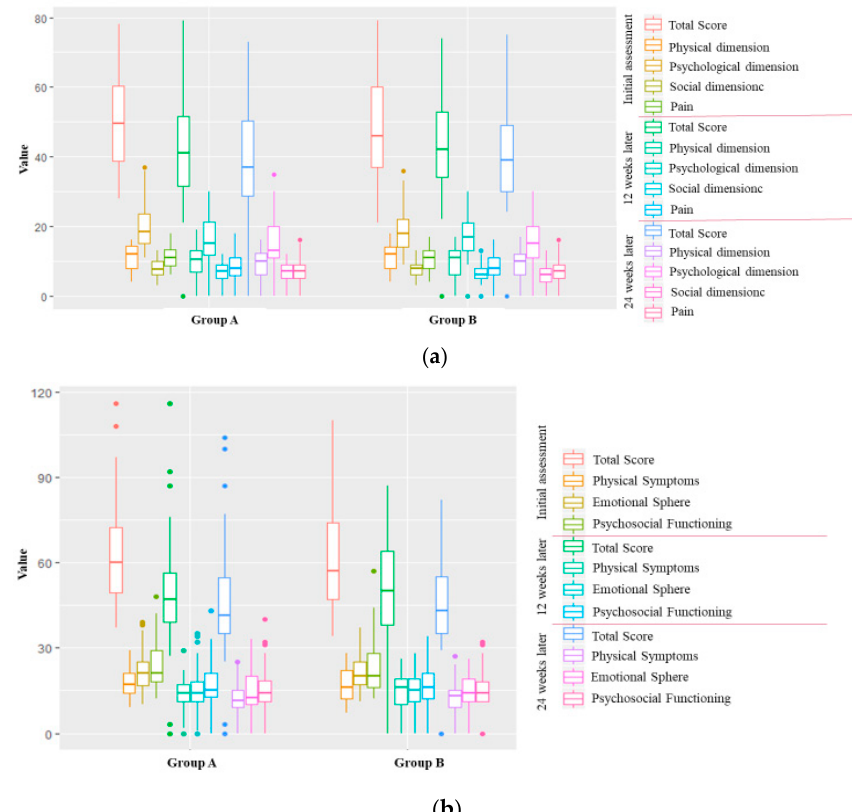
Figure 2. Box plots of changes in quality of life in the consecutive weeks of observation in the study groups. ( a ) Changes in quality of life according to the CIVIQ scale. Correlation between wound healing progress and changes in quality of life (total CIVIQ score): R (Group A) = 0.87, p = 0.000; R (Group B) = 0.85, p = 0.000. ( b ) Changes in quality of life according to the SKINDEX-19 scale. Corre- lation between wound healing progress and changes in quality of life (total Skindex-19 score): R (Group A) = 0.79, p = 0.001; R (Group B) = 0.76, p = 0.000. R—Spearman’s rank correlation coefficient; (A)—group A; (B)—group B; p —value. The mean pain intensity decreased significantly during the intervention; after 12 weeks, it decreased by 3.07 points in group A, and by 2.49 points in group B. In the fol- lowing 12 weeks, the change in average pain intensity occurred only in group A (by an- other 0.13 points). There were no intergroup differences in pain intensity, either at the baseline or during the intervention. Pain intensity was poorly correlated with the initial wound surface (negligible positive correlation in group A, weak in group B, both statisti- cally significant) and strongly correlated with the wound healing process (very strongly positive in group A, strongly in group B, both statistically significant) (Figure 3).